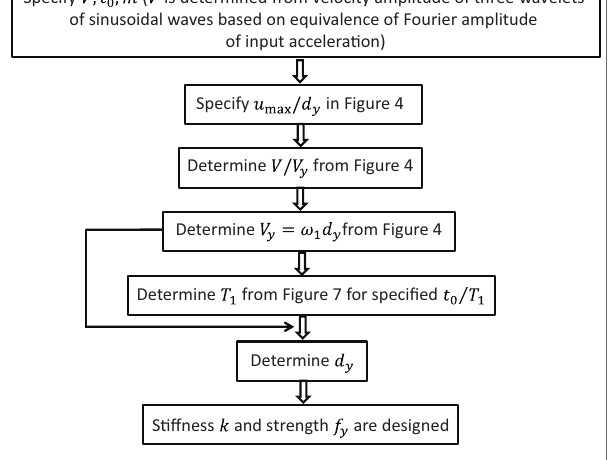
FigUre 14 | Flowchart for design of stiffness and strength